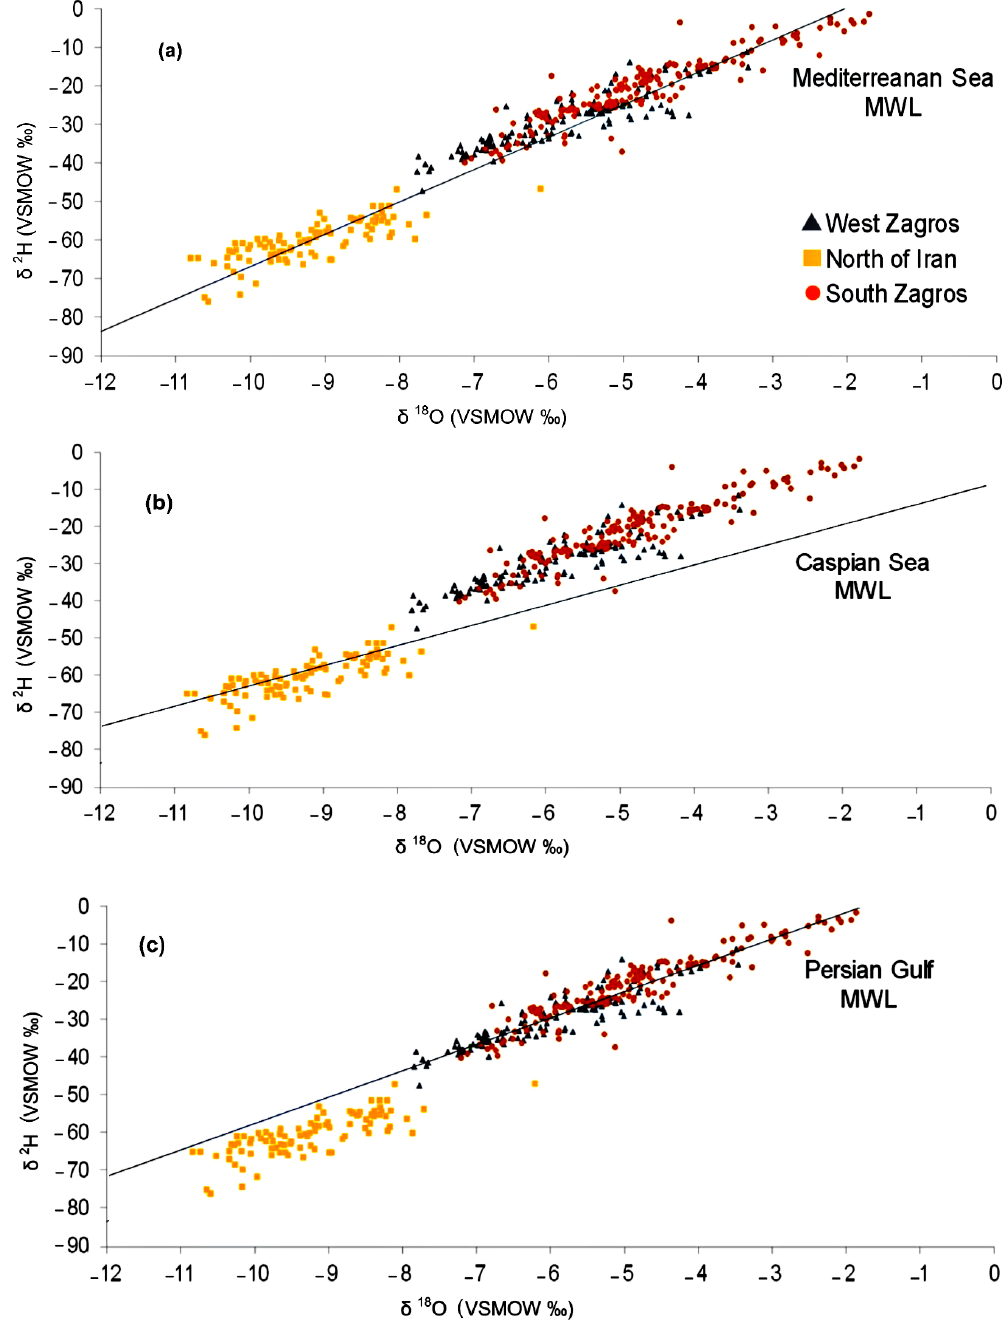
Figure 8. Plotting karstic springs δ 18 O and δ 2 H across Iran on the Mediterranean Sea ( a ), the Caspian Sea ( b ), and the Persian Gulf ( c ) MWLs. (The Mediterranean Sea, the Persian Gulf, and the Caspian Sea MWLs are taken from Figure